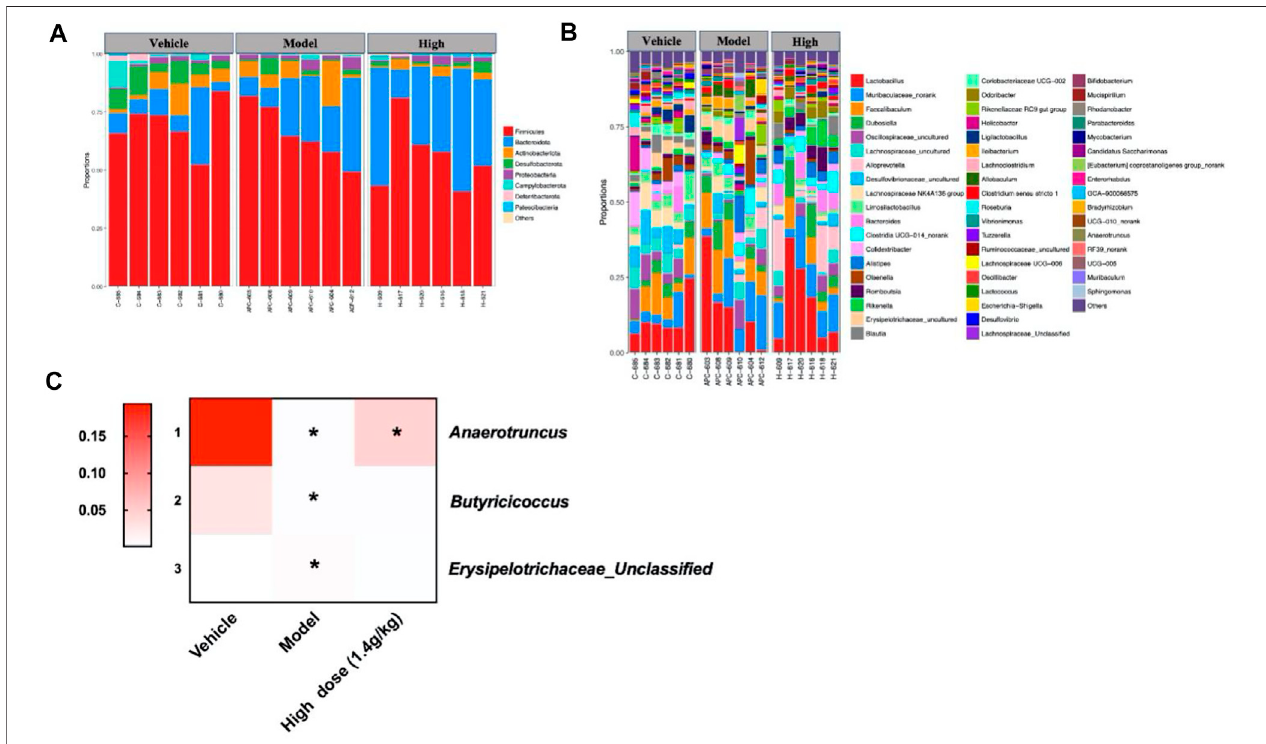
FIGURE 7 | Gut microbial community structure in Apc min/+ mice after QCWZD treatment. (A) Microbial community bar plot according to phylum. (B) Microbial community bar plot according to genus. (C) Heatmap of gut microbiota abundance at the phylum and genus levels. High dose: 1.4 g/kg, * p < 0.05.